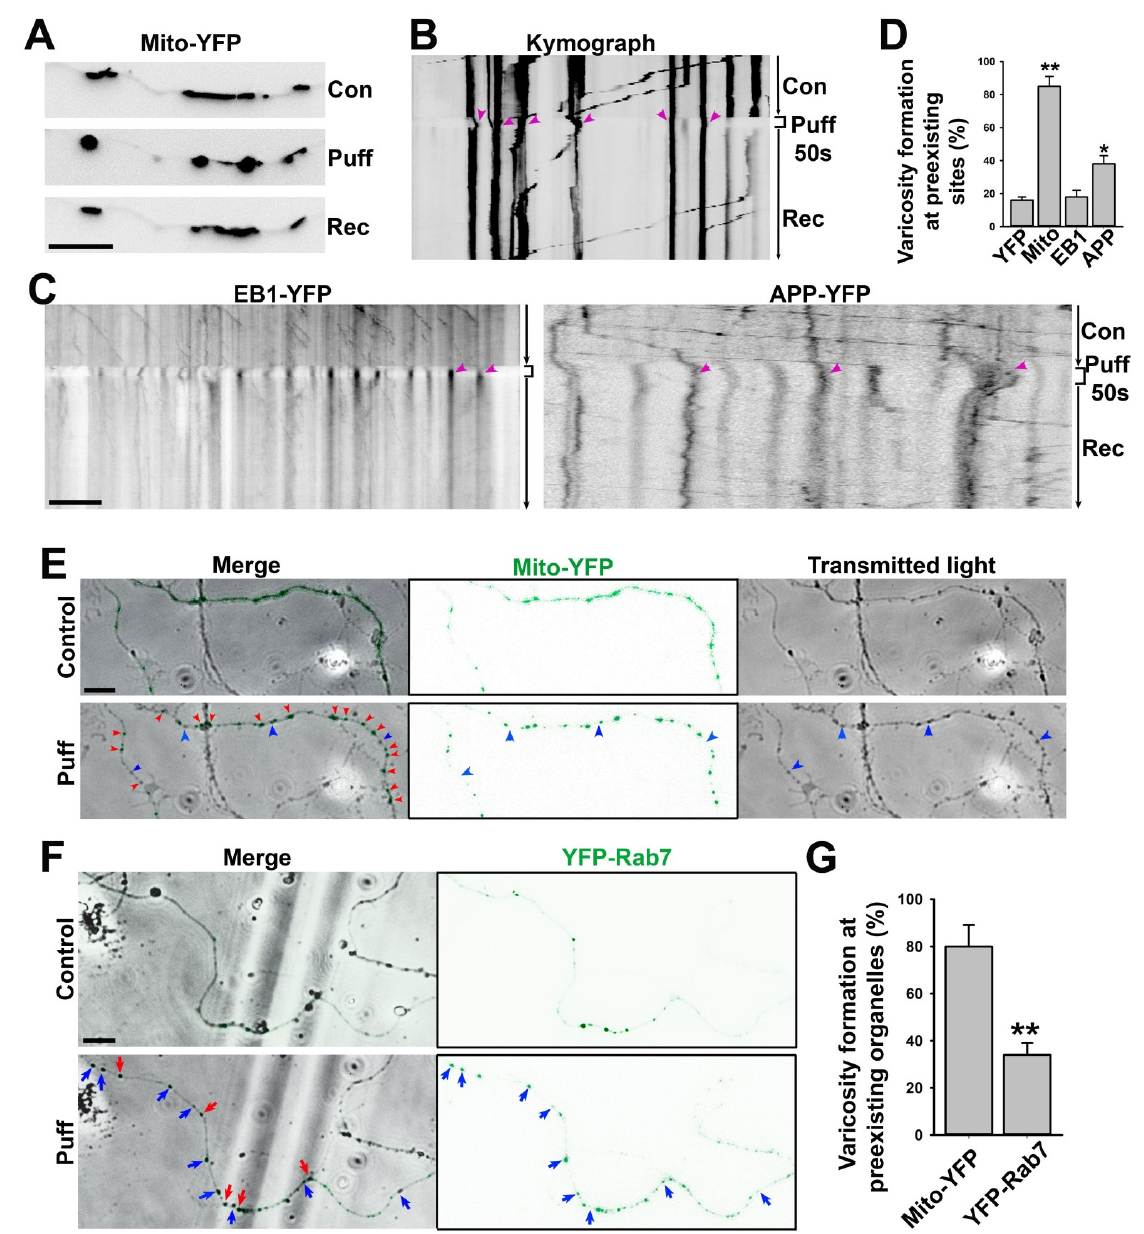
Figure 4. Mitochondria are preferred sites for puffing-induced transient formation of axonal var- icosities. ( A ) An axon expressing mito-YFP before (con), during (Puff), and after puffing (Rec). YFP fluorescence signals are inverted. ( B ) Kymograph of the movement of mito-YFP puncta along the axon in ( A ). Red arrowheads, YFP puncta after puffing located at the preexisting site. ( C ) Kymo- graphs of EB1-YFP (left) and APP-YFP (right) movement along axons before, during, and after puff- ing. Most YFP punta were induced by puffing at new sites and slowly resolved afterwards. ( D ) Percentage of YPF puncta after puffing located at the same sites prior to puffing. One-way ANOVA followed by Dunnett’s test: *, p < 0.05; **, p < 0.01. n ~12 for each condition. ( E ) Live-cell imaging for mito-YFP (green) and transmitted light before and after puffing during varicosity induction. Red